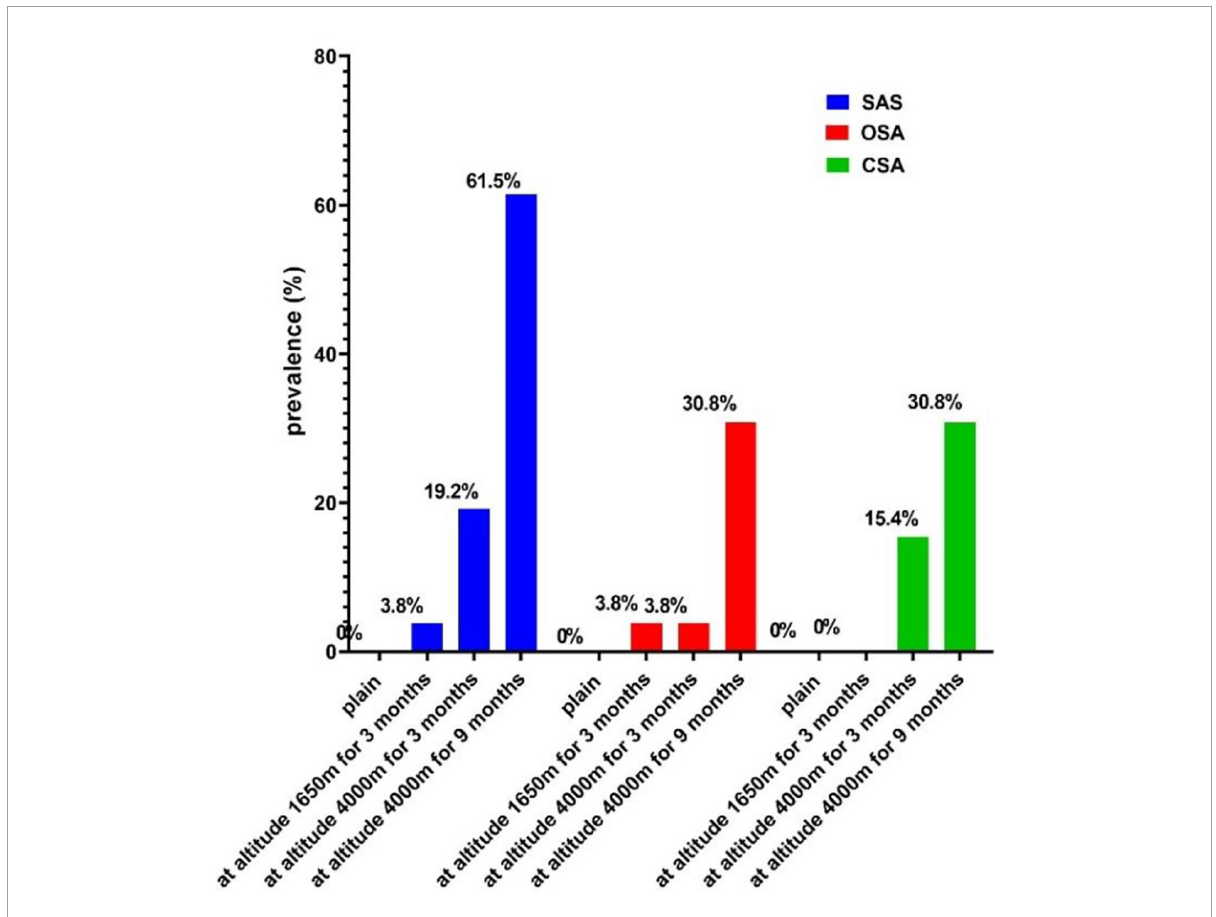
FIGURE2 The prevalence of SAS at different altitudes. SAS, sleep apnea syndrome; OSA, obstructive sleep apnea; CSA, central sleep apnea.